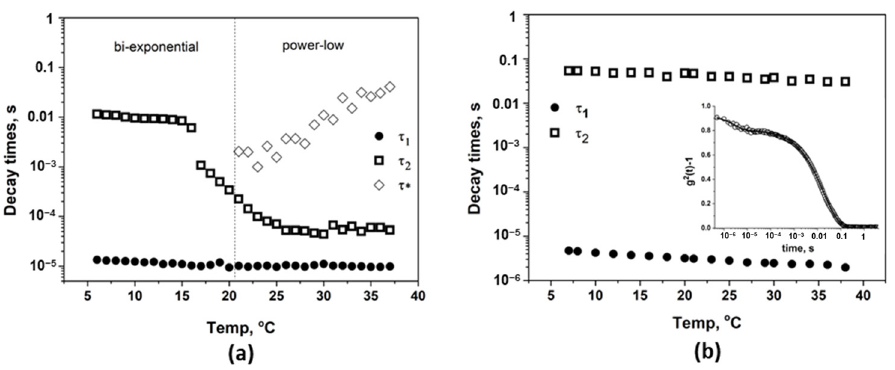
Figure 10. Temperature dependence of the decay times for 17% poloxamer solution ( a ) and for 1% CMP 0.95 solution ( b ). The intensity autocorrelation function of CMP 0.95 solution (1%) at 20 °C is presented in the inset ( b ).